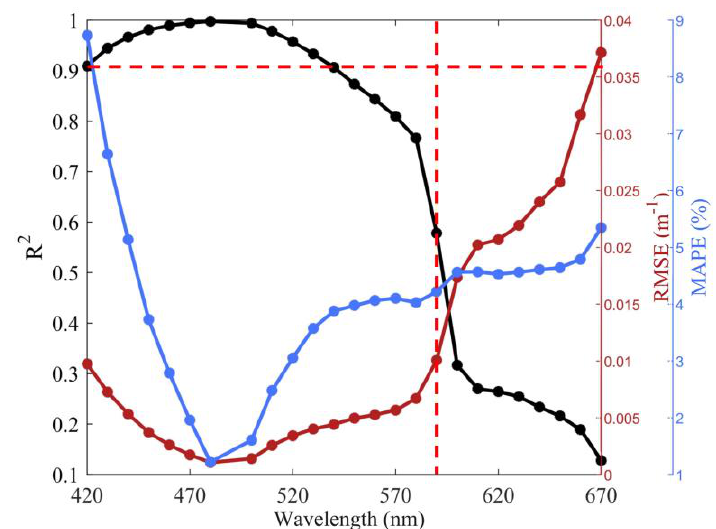
Figure 9. Accuracy evaluation of the linear regression results.